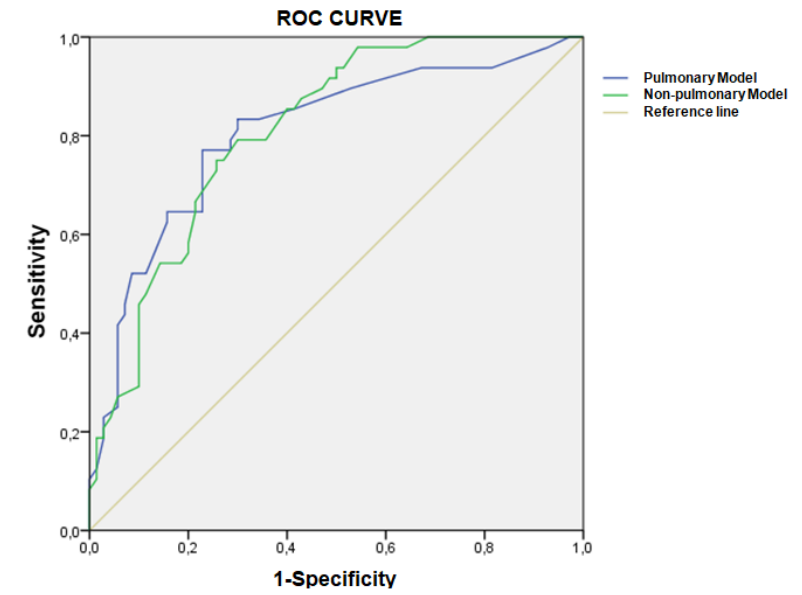
Figure 2. Receiver operating characteristic curves comparing the final clinical pulmonary model and final non-pulmonary model as predictors of poor 6MWT performance (<350 m).